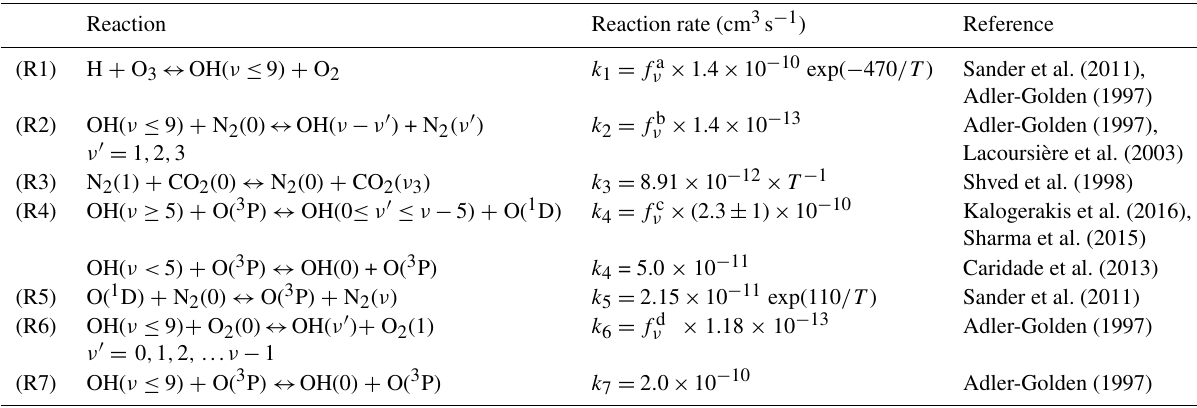
Table 1. Significant collisional processes used in model.